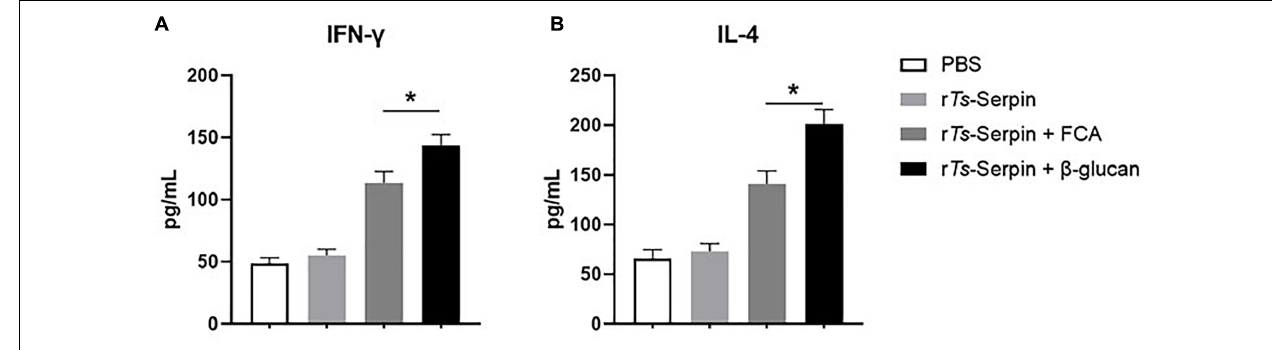
FIGURE 3 | Analysis of cytokine production from CD4 + T cells. (A) The level of IFN- γ was measured by ELISA one week after the final immunization. (B) The level of IL-4 was measured by ELISA one week after the final immunization. The data are the mean ± SD of each group ( n = 10) from three independent experiments. * P < 0.05 as indicated by the lines.